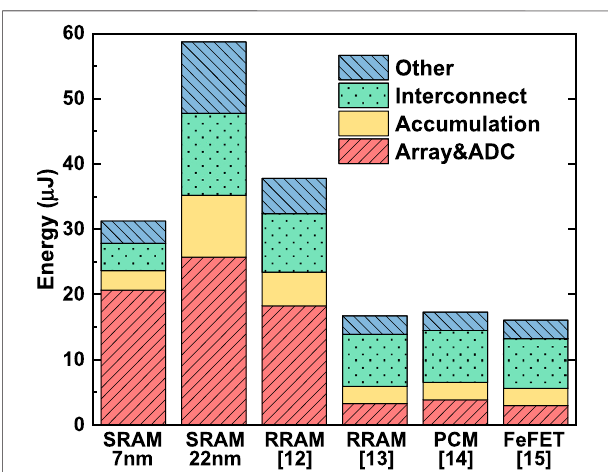
FIGURE 9 | Energy breakdown of CIM accelerators on VGG-8 for CIFAR-10, based on SRAM (at 7 and 22 nm), and reported eNVM devices (assumed at 22